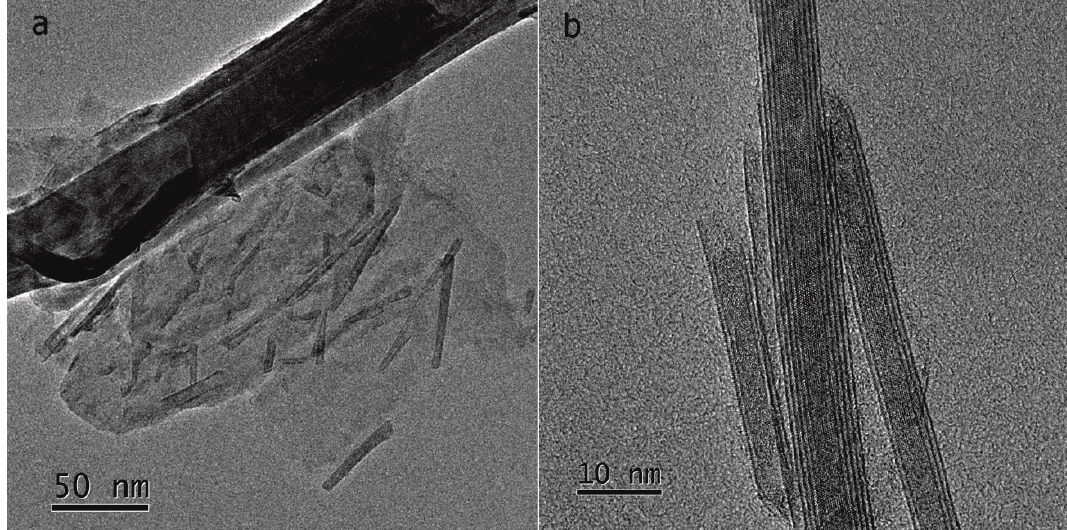
nanotubes obtained by plasma ablation of 2 at 600 W for 40 min: ( a ) A large number of 2 nanotubes by sonication. 2